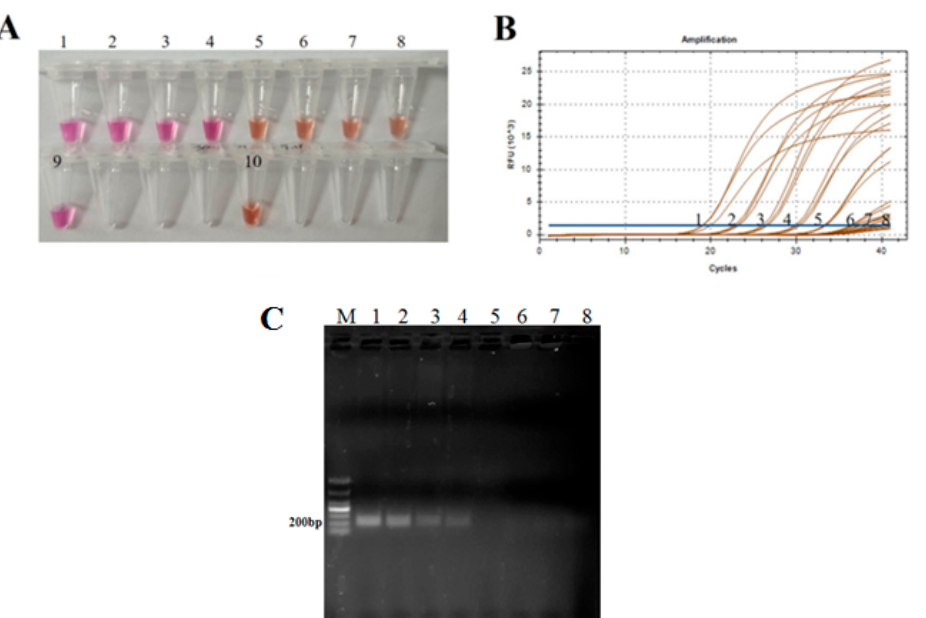
Figure 5. The comparison of analytical sensitivity of the visual naked-eye RT-LAMP assay between the RT-qPCR and conventional RT-PCR. LOD of the naked-eye visual RT-LAMP ( A ), the RT-qPCR ( B ), and the RT-PCR ( C ) assays for the amplification of FMDV 3D gene RNA transcript standards. Tubes, lines, and lanes 1–8 represent ten-fold serial dilutions (from 10 7 to 10 0 copies/ µ L) of the RNA transcripts. Tube 9 and 10 represent positive and negative control, respectively.